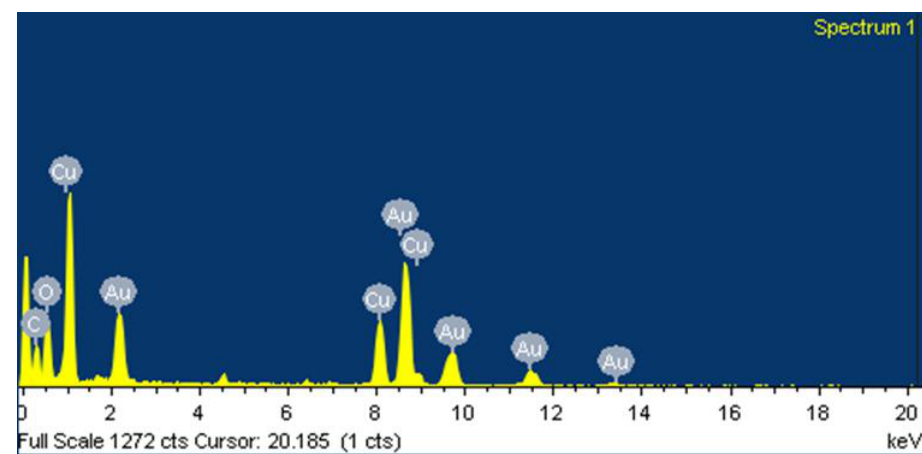
Figure 5. TEM-EDS of the Au-GO nano-hybrid synthesized at the 13.2 Jcm − 2 laser fluence.